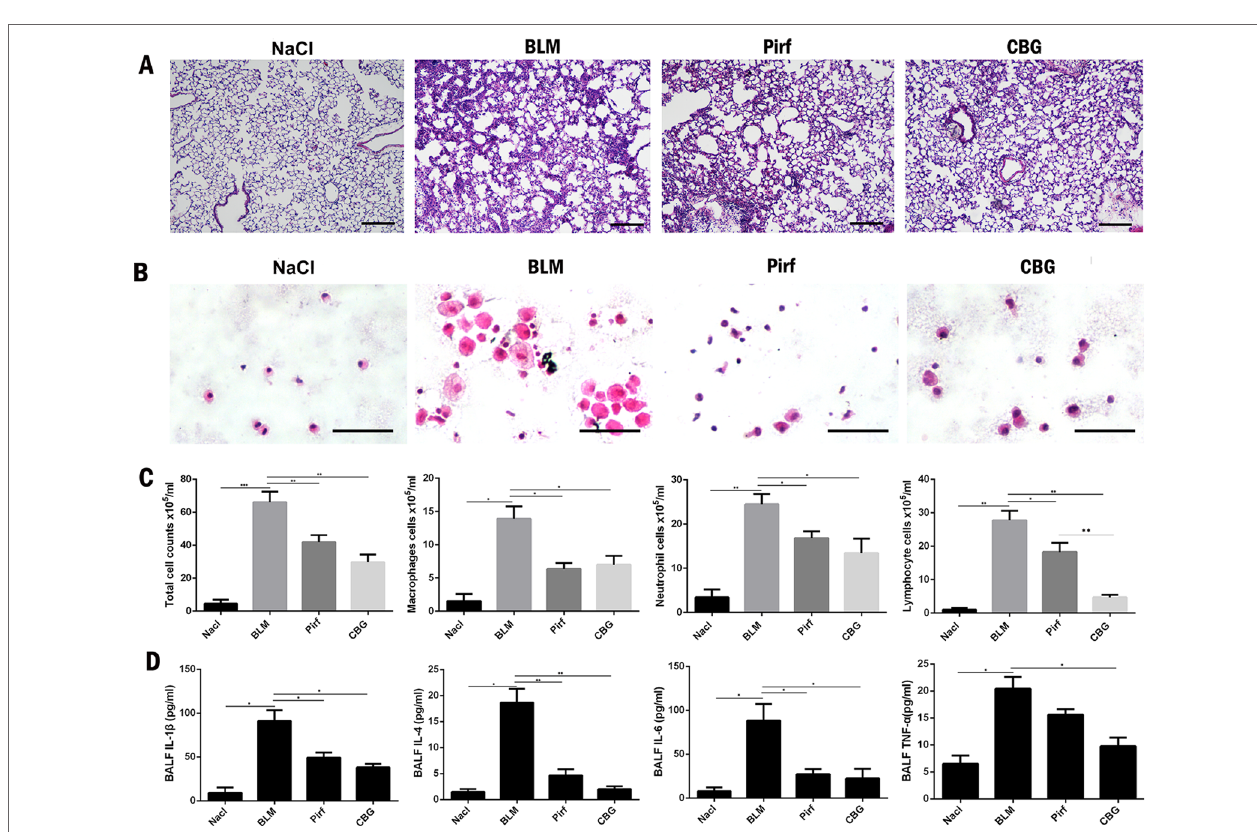
FIGURE 7 | Cinobufagin reduced the inflammatory response in bleomycin-treated mice. (A) HE staining of left lung tissues in each group. (B) HE staining of inflammatory cells in the BALF. Representative visual fields of HE staining from NaCl group, BLM group, Pirfenidone group and cinobufagin group, respectively. Cells were mainly macrophages, neutrophils and lymphocytes. Original magnification, ×200. (C) Total cell, macrophages, neutrophils and lymphocytes from BALF in each groups were counted on day 7. (D) The expression of inflammatory factors including IL-1 β , IL-4, IL-6 and TNF- α in BALF were detected by ELISA kit. Data are presented as mean ± SD (n = 6).*P < 0.05; **P < 0.01; ***P <